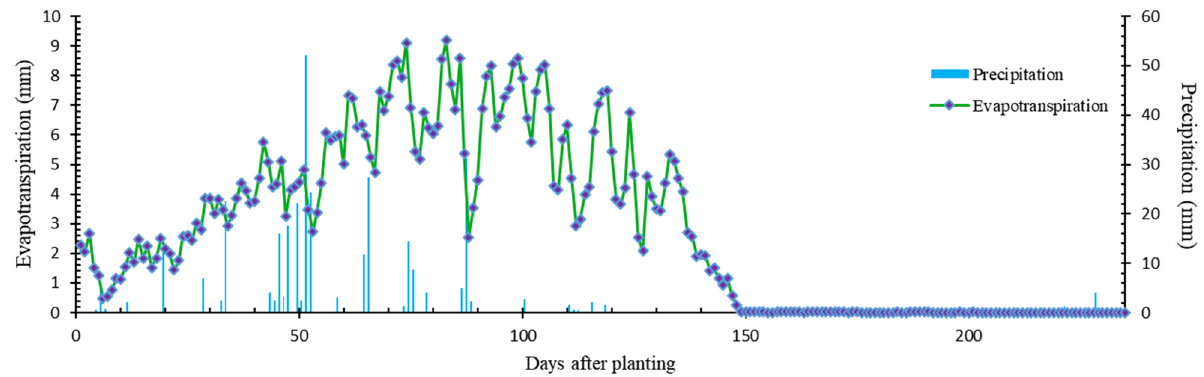
Table 3. The initial soil water content and soil salinity.